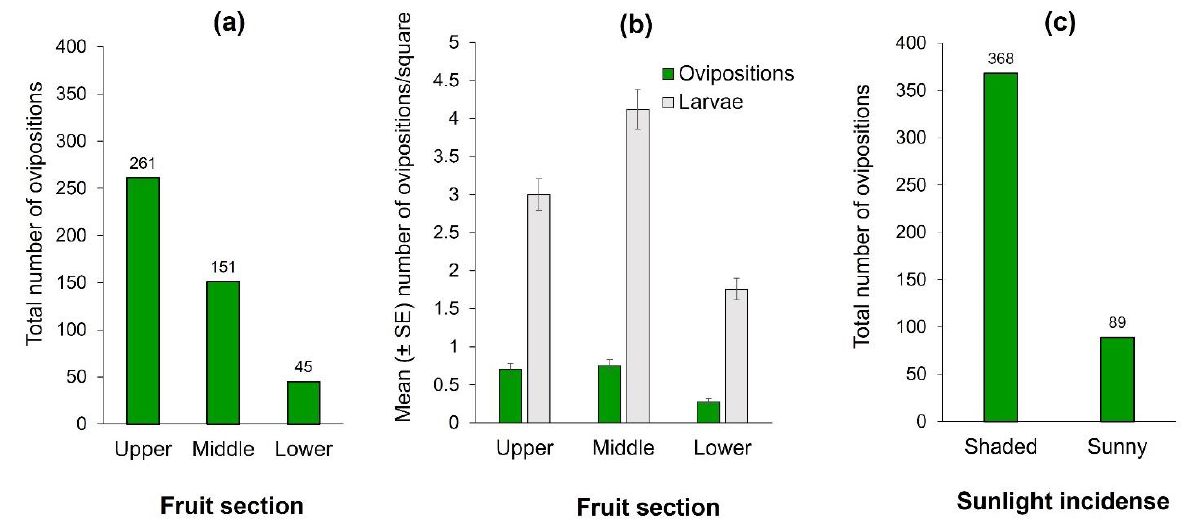
Figure 2. Ovipositions and infestation of Anastrepha obliqua on 75 “Criollo” mango fruit of Study 1. ( a ) Total number of A. obliqua ovipositions by fruit section; ( b ) Number of A. obliqua ovipositions and larvae per square according to fruit section (upper, middle, or bottom sections) in ‘Criollo’ mangos (mean ± SE) independent of sunlight incidence into fruit (i.e., shaded or sunny parts). Oviposition records correspond to the mean of observations conducted over an eight hour/day period. Infestations correspond to the mean of two days of natural infestation (i.e., mangos exposed to female oviposition activity); ( c ) Ovipositions according to sunlight incidence on fruit.